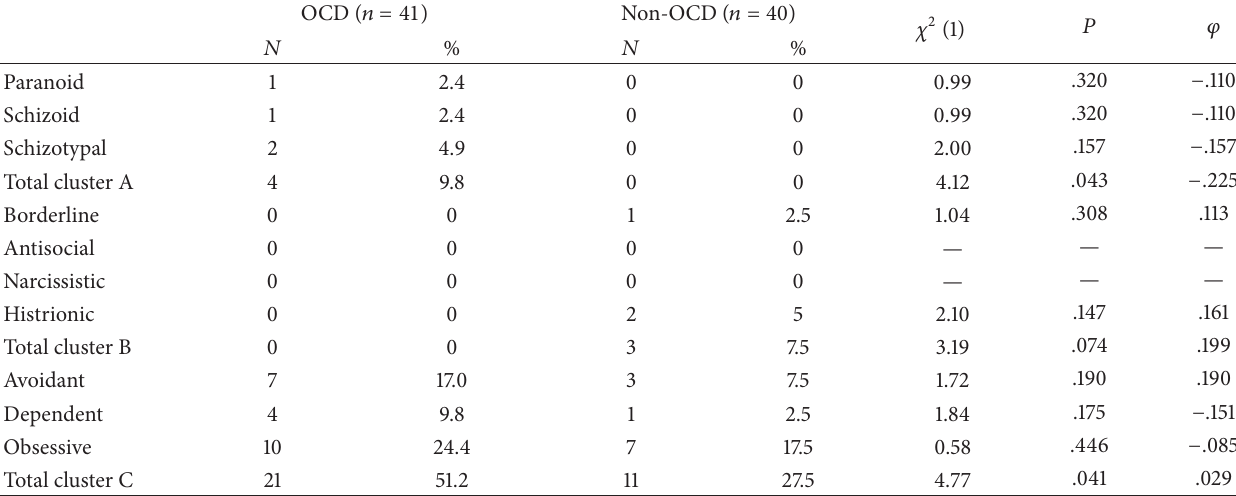
Table 3: PD comorbidity in clinical subjects with OCD and without